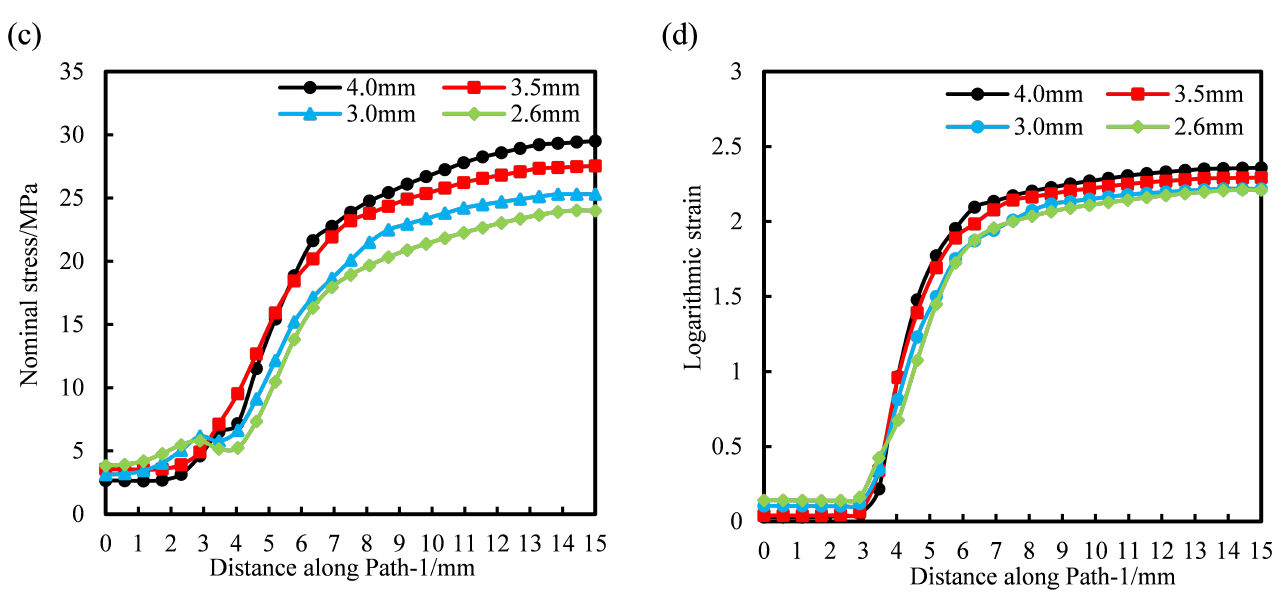
Figure 21. Variation law of stress and strain along Path-Y and Path-1 with the diameter of the pre-punched hole. ( a ) Nominal stress of 90° bar along Path-Y, ( b ) logarithmic strain of 90° bar along Path-Y, ( c ) nominal stress of the diagonal bar along Path-1, ( d ) logarithmic strain of the diagonal bar along Path-1.